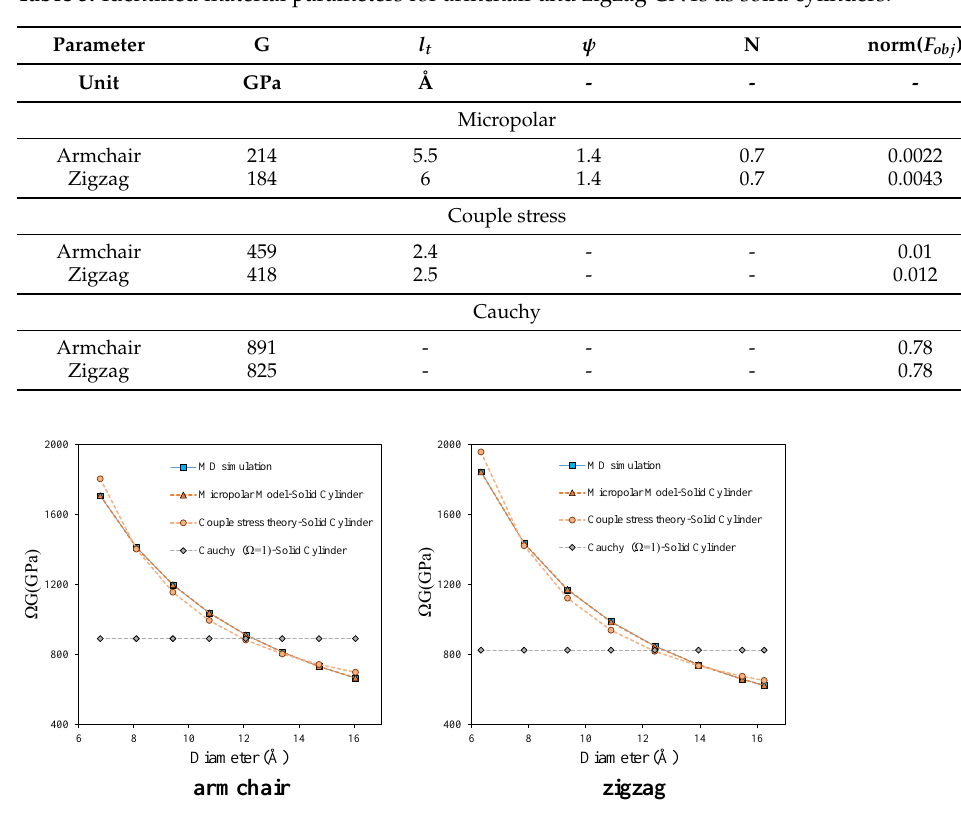
Figure 7. Comparison of apparent shear modulus from micropolar and couple stress and Cauchy models with MD results-solid cylinder assumption.